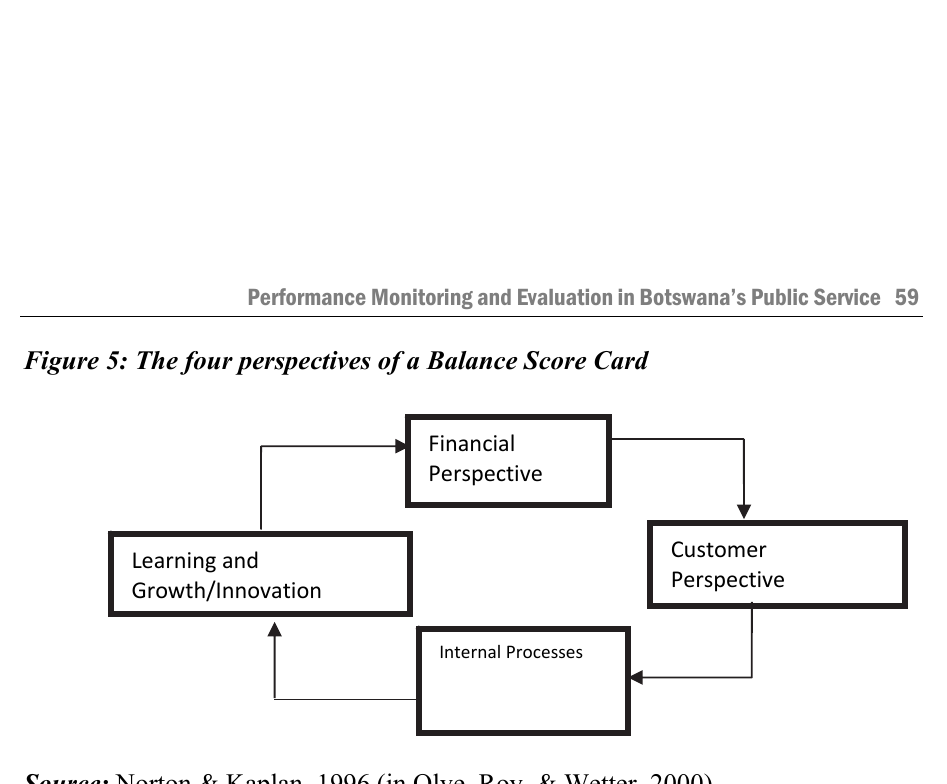
Performance Rating Scales